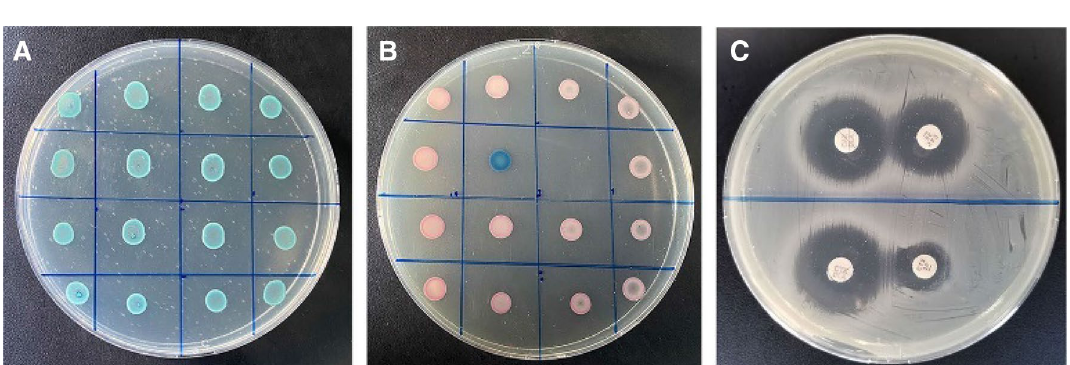
Figure 2. ( A ) Identification of Escherichia coli strains by CHROMagar orientation medium; ( B ) Identification of ESBL-producing E. coli strain by CHROMagar orientation medium; ( C ) Identification of ESBL-producing E. coli strain by double disk synergy test. Original Images of full-length gels are presented in Supplementary Figs. 1, 2, and